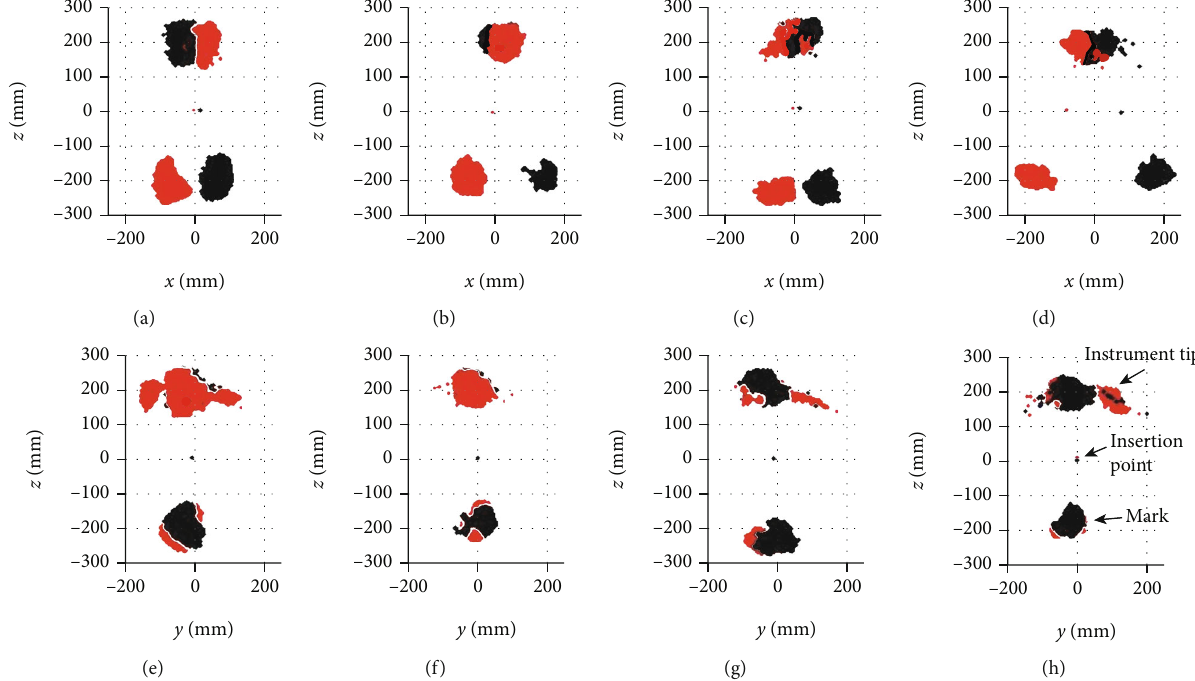
Figure 7: Position of the mark, insertion point, and instrument tip. (a – d) The xz plane view of instrument position in Groups A, B, C, and D. (e – h) The yz plane view of instrument position in Groups A, B, C, and D (red points: left instrument; black points: right instrument). The middle point of A and B (O) was de fi ned as the origin point. O → B was the positive direction of the x -axis, and O → C was the positive direction of the z -axis as shown in Figure